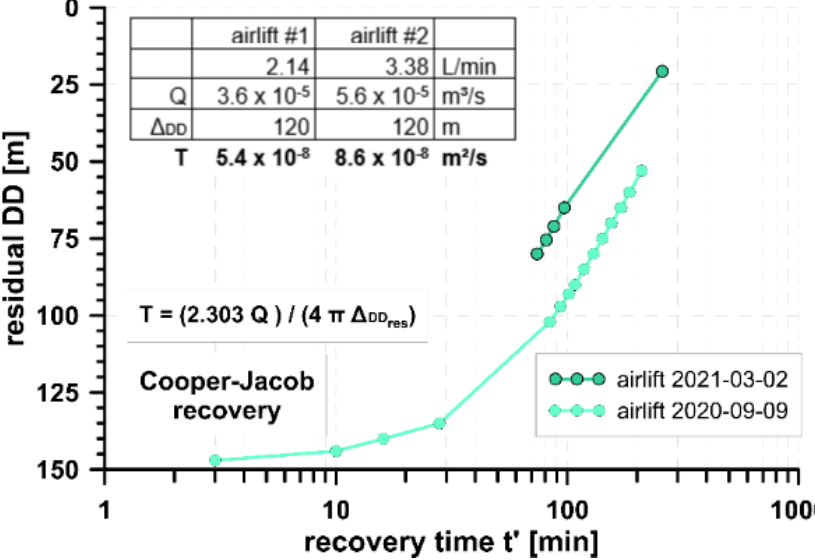
Figure A1. Results of well recovery tests according to Cooper–Jacob after two airlift